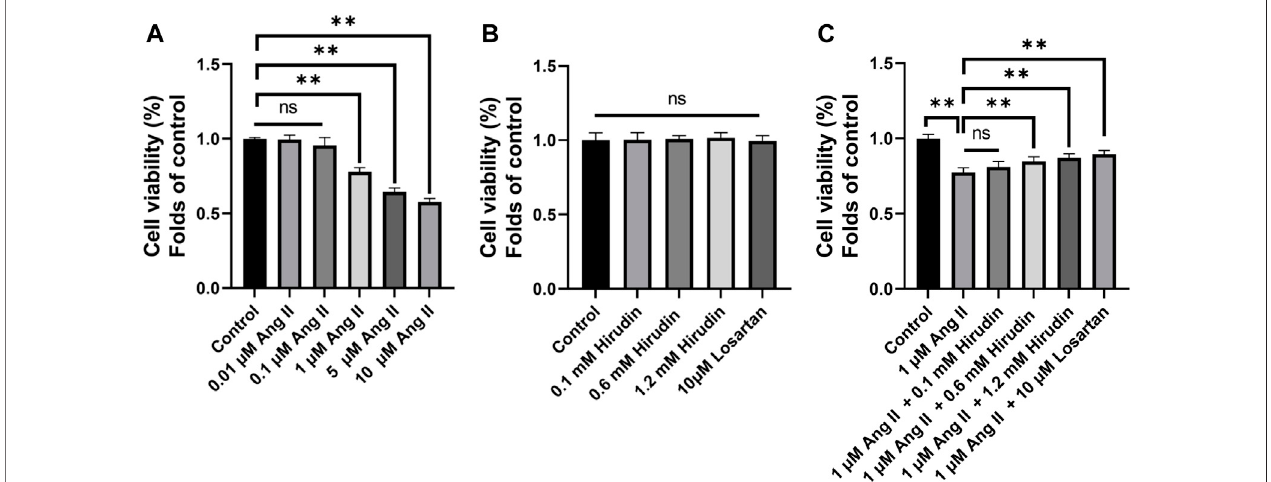
FIGURE6|(A) H9c2cellsweretreatedwith(0.01,0.1,1,and10 μ M)AngIIfor24 h,respectively. (B) H9c2cellsweretreatedwith(0.1,0.6and1.2 mM)hirudinand 10 μ Mlosartanfor24 h (C) H9c2cellsweretreatedwith1 μ MAngIIand (0.1,0.6and 1.2 mM)hirudinand 10 μ Mlosartanfor24 h. Barsrepresent themean±SD, n =5 ** p <